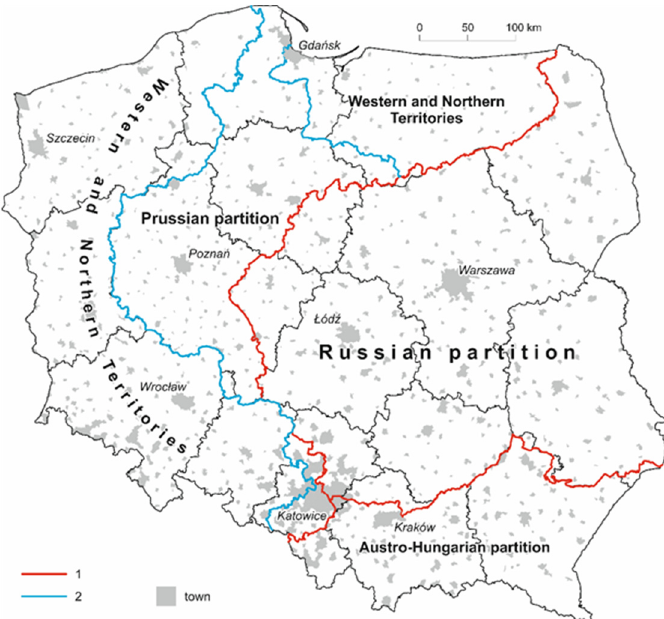
Figure 1. Course of historical borders in the current area of the country. Source: Own study. 1—an illustrative border of division into three Russian, Prussian, and Austro-Hungarian partitions before World War I against the background of the current Polish territory. 2—an illustrative Polish-German border from the interwar period against the background of the current division of Polish territory.